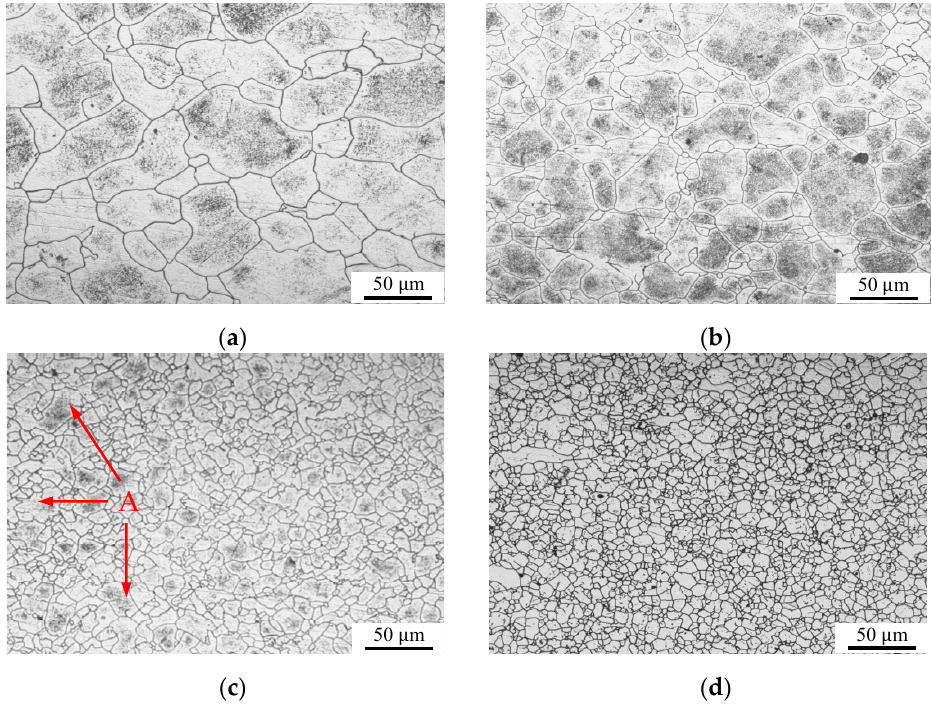
. ε = 0.01 s ´ 1 : ( a ) initial